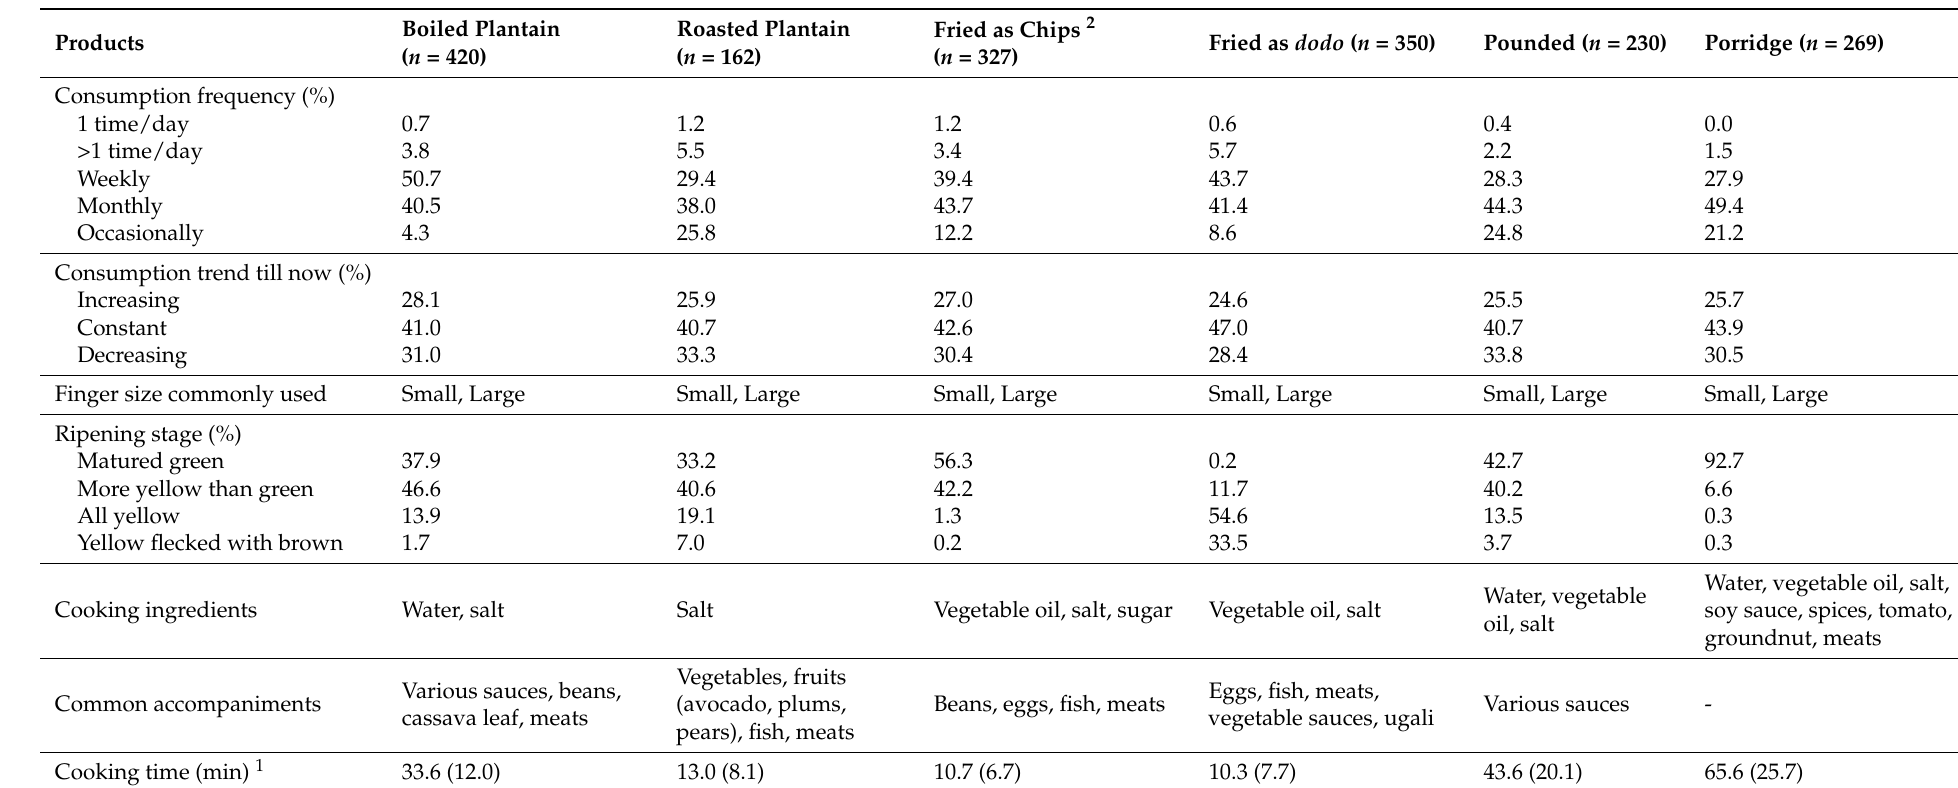
Table 2. Consumption characteristics and cooking methods of plantain-based products in